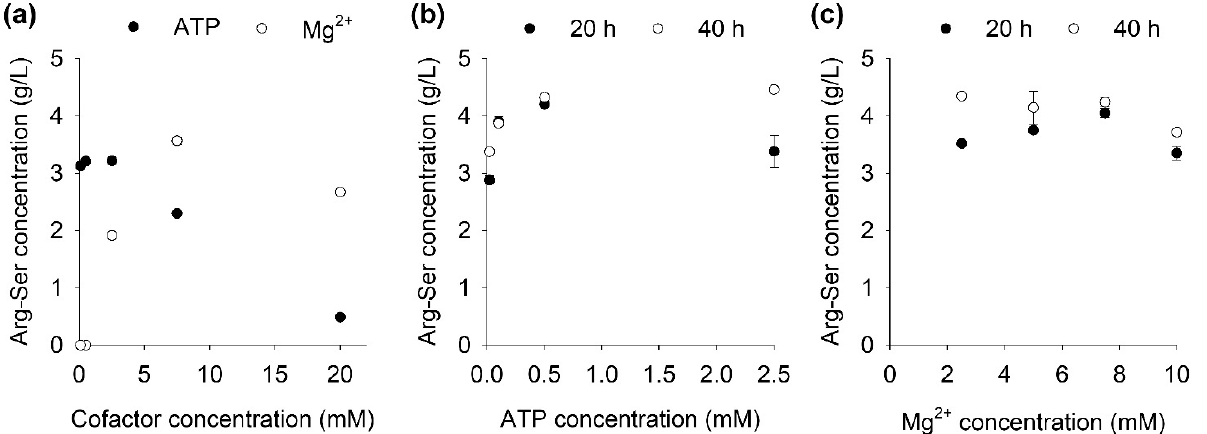
Figure 3. Effect of two cofactors ATP and Mg 2+ on Arg-Ser production. ( a ) ATP and Mg 2+ with 40 mM AA and AcP. ( b ) ATP with 50 mM AA and AcP at 20/40 h reaction time. ( c ) Mg 2+ with 50 mM AA and AcP at 20/40 h reaction time. Reactions were set up in duplicate; data are presented as mean with error bars representing the range.